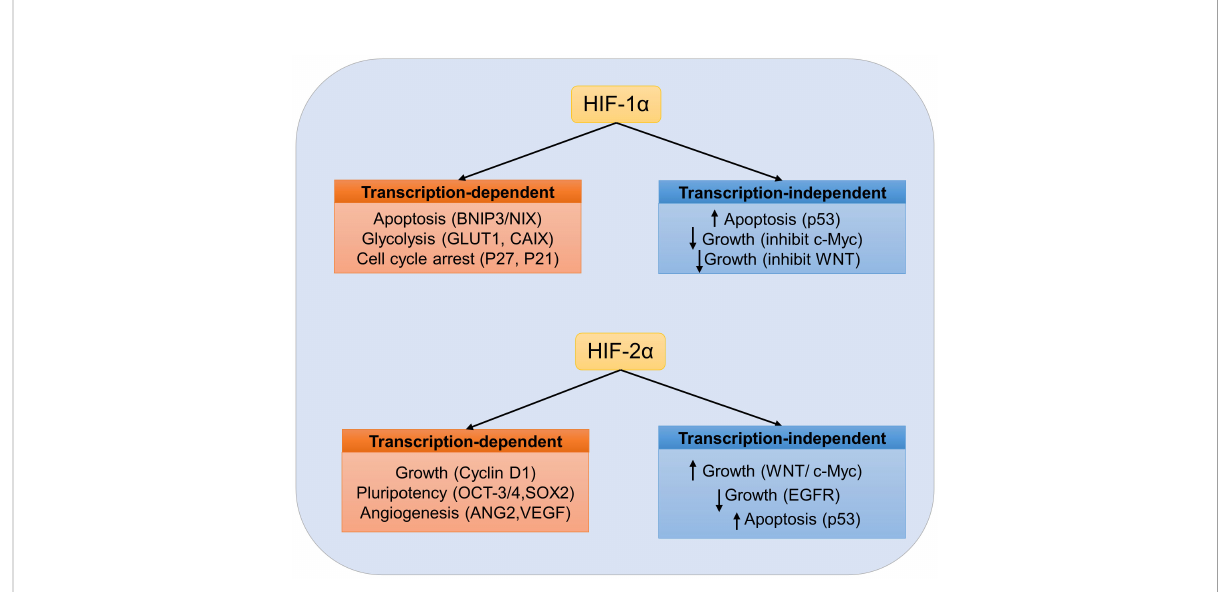
FIGURE 2 Speci fi c role of HIF in tumor cells. Transcription-dependent and independent targets of HIF-1 a or HIF-2 a are listed. No overlapping HIF targets are listed. Depending on the cellular environment, activation of HIF transcription factors may have pro-tumor or anti-tumor